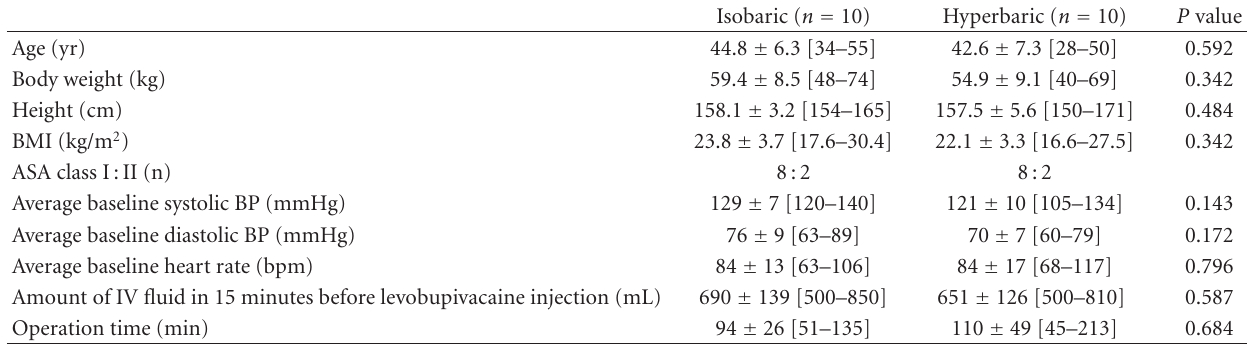
Table 1: Characteristics of patients receiving spinal anesthesia with isobaric or hyperbaric levobupivacaine for gynecologic surgery. Values are mean ± SD [min–max] or number of